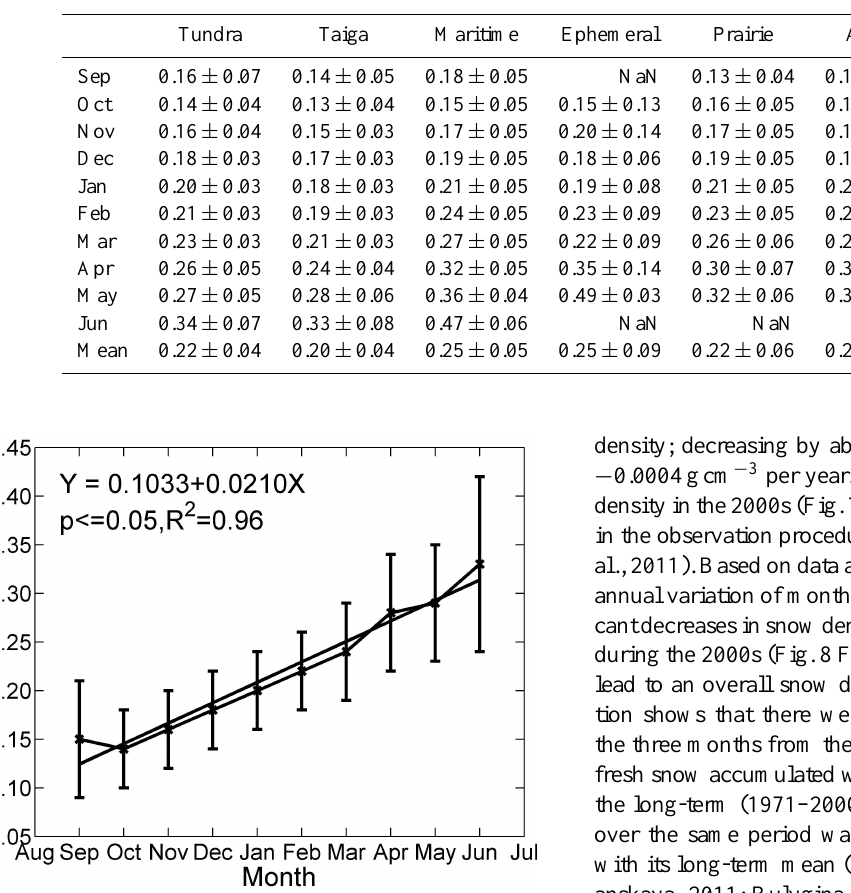
Fig. 5. Monthly mean snow density at 1259 stations across the former USSR from 1966 to 2008. The asterisk is the computed monthly mean snow density; the error bar represents one standard deviation from the mean over the entire period. The thick line is a linear regression trend. In the equation, y stands for snow den- sity ingcm − 3 , and x for time in months (from September to June). September was the first month in a snow cover year, therefore, x ranged from month 1 (September) to month 10 (June) in the sim- ulation of monthly snow density. p is the confidence level for the coefficient estimates, and R 2 is the goodness of fit